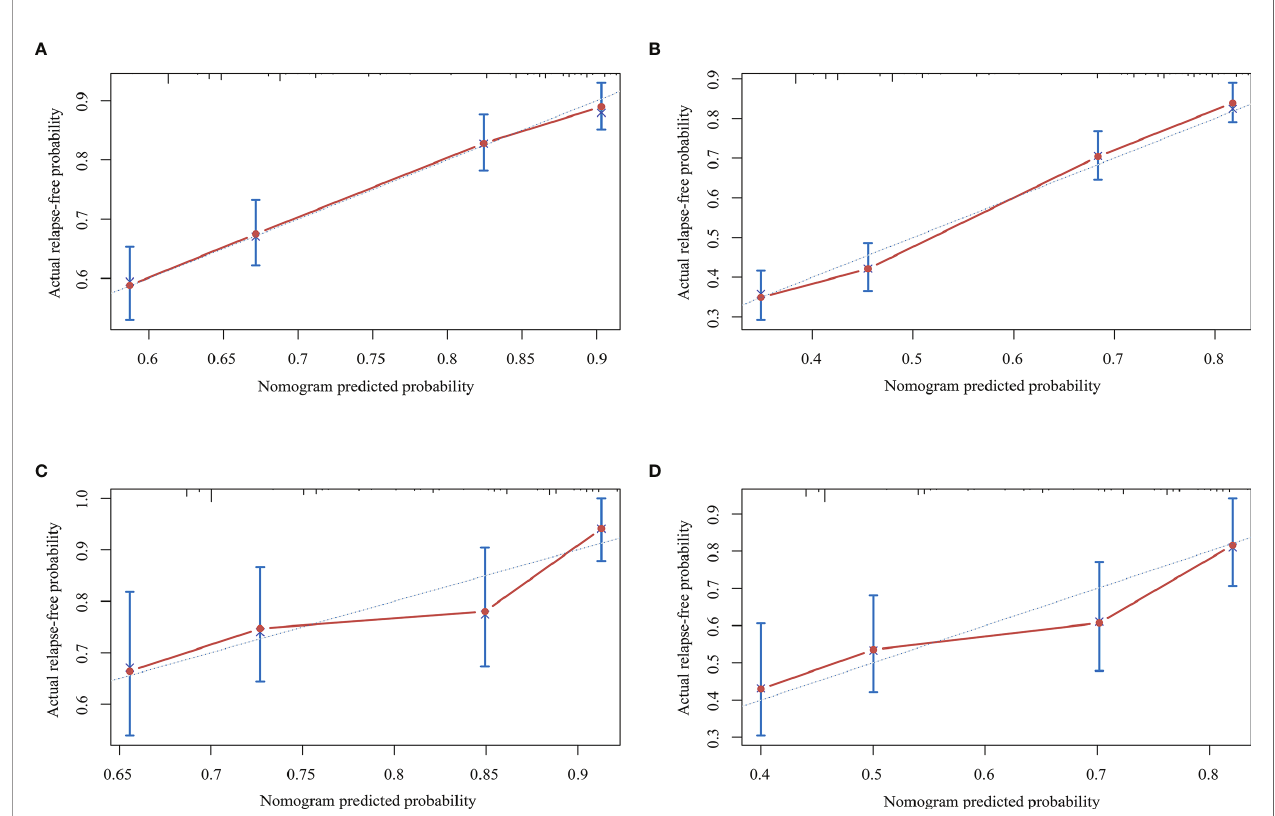
FIGURE 3 | Calibration curves for the nomogram in the primary and validation cohorts. (A) Calibration curve for predicting the 1-year relapse-free probability in the primary cohort. (B) Calibration curve for predicting 2-year relapse-free probability in the primary cohort. (C) Calibration curve for predicting 1-year relapse-free probability in the validation cohort. (D) Calibration curve for predicting 2-year relapse-free probability in the validation